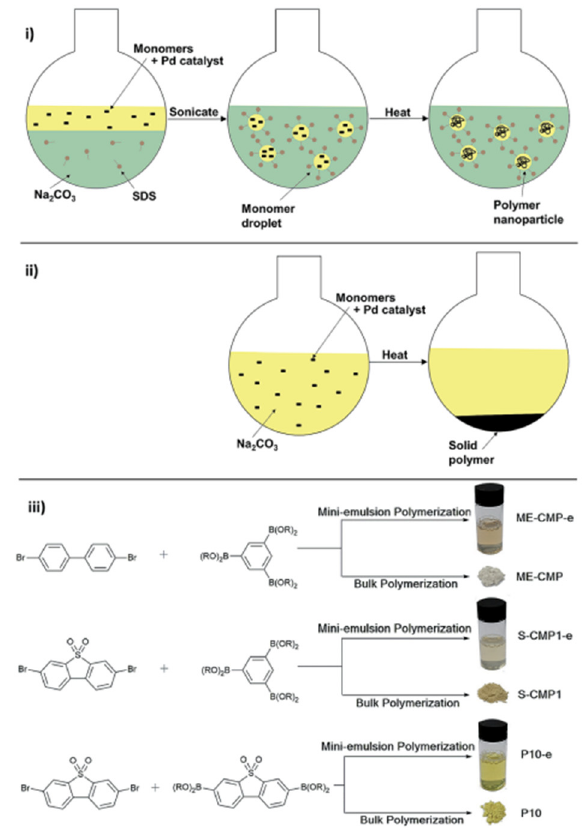
Figure 36. ( i ) Mini-emulsion polymerization illustration. ( ii ) Bulk polymerization illustration. ( iii ) Structures of monomers and pictures of products studied to compare the bulk HER to the nanopar- ticle HER [Figure from ref. [156] under CC-BY 3.0 International License].